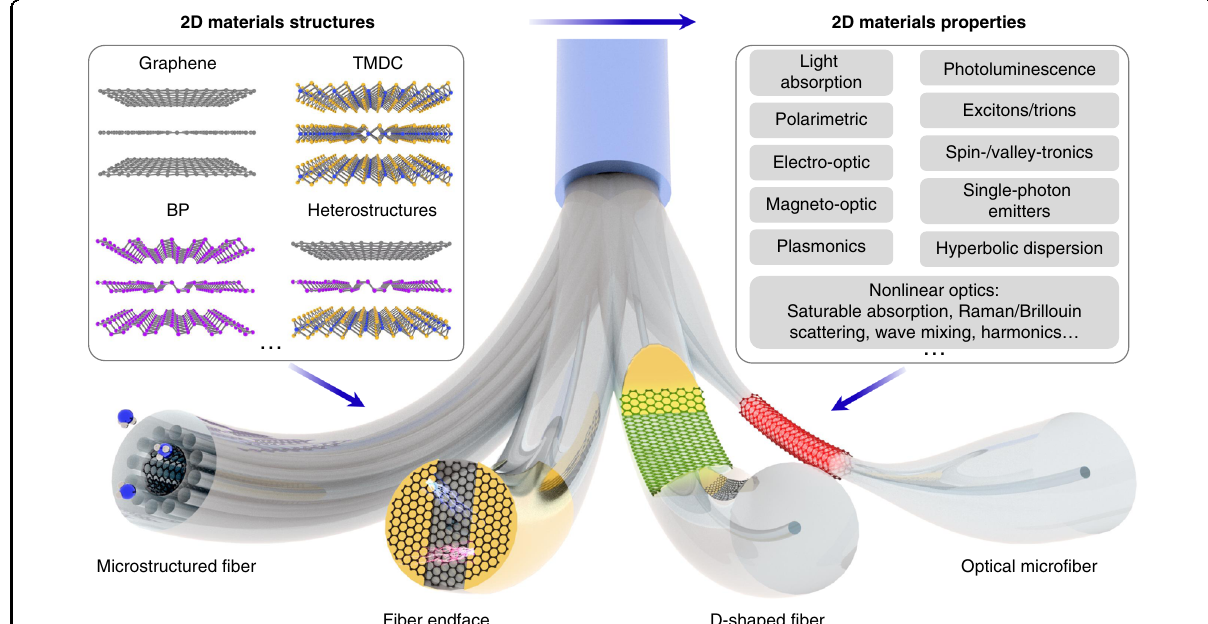
Fig. 1 Schematic of 2D materials integration to optical fi ber platform. Left box illustrates the crystal structures of multilayered graphene, transition metal dichalcogenides (TMDC), black phosphorus (BP) and their heterojunctions. Right box lists typical optical and optoelectronic properties of 2D materials. 2D materials are fl exibly assembled in microstructured fi ber, fi ber endface, D-shaped fi ber and optical micro fi ber for versatile